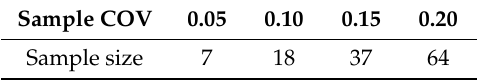
Table 5. Sample size from the normal distribution.